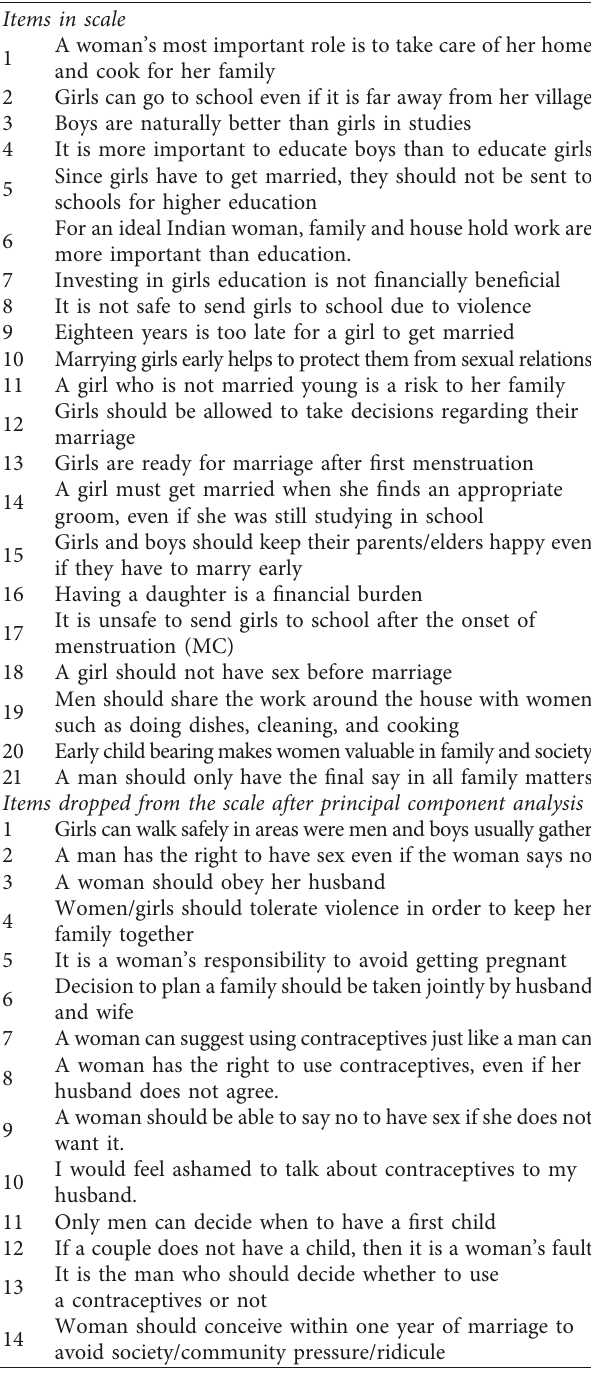
Table 4: Description of items in GEMS